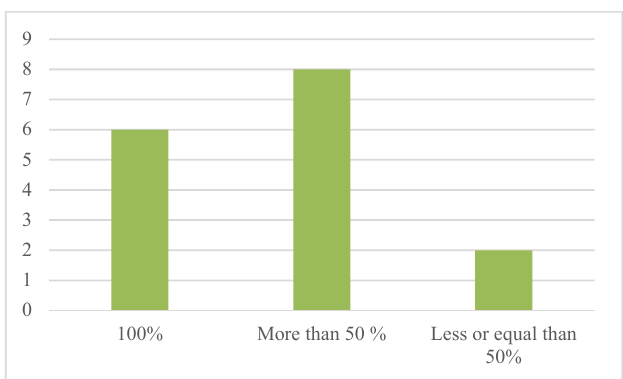
Figure 4. Number of second choice work teams with more than 50% correspondence using the fusion of KSA models and